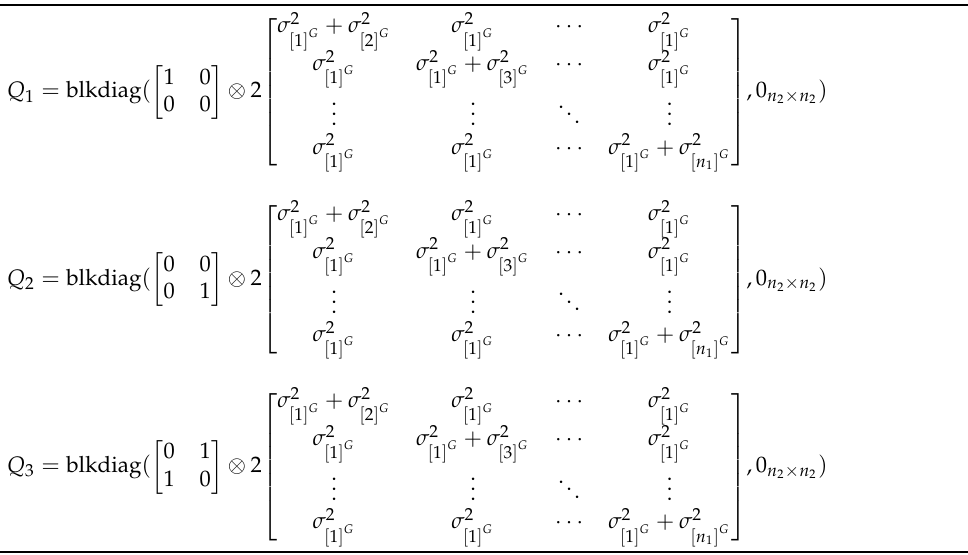
Table 1. Six cofactor matrices related to six LS-VCE